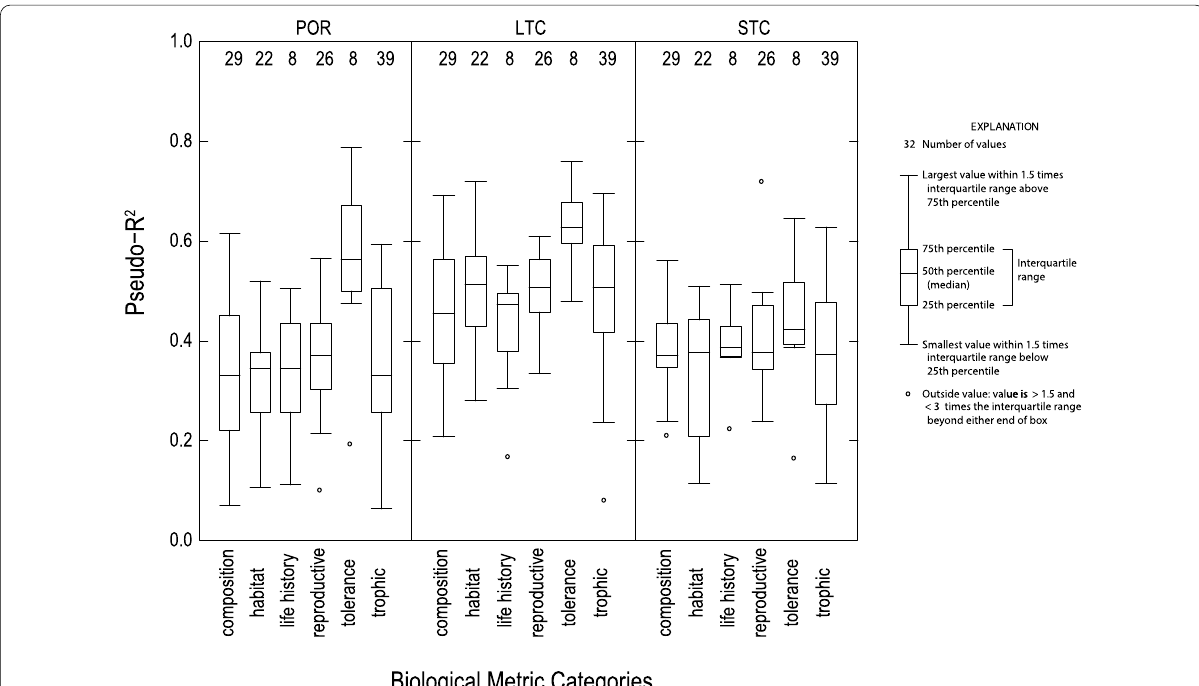
Fig. 2 Tukey boxplots showing the distribution of pseudo- R 2 values among final censored regression models in each of the six categories of biological metrics for three hydrologic datasets (POR, LTC, and STC; Krall et al. 2022); hydrologic datasets are identified above each set of boxplots, sample sizes for each biological metric category are represented at the top of the plots, and outliers are represented by open circles